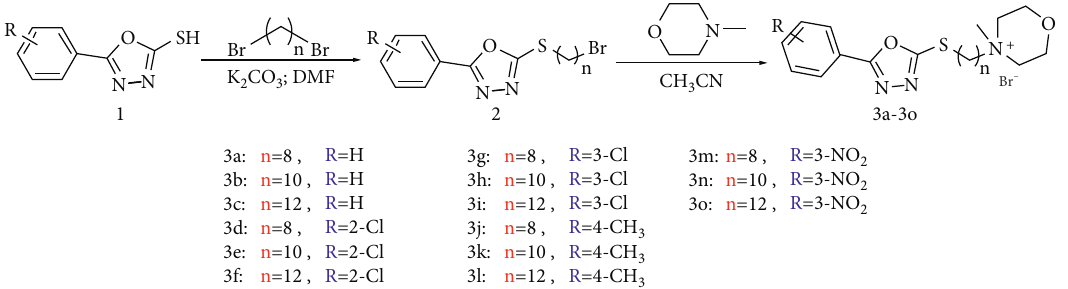
Figure 2: Synthetic route for target compounds 3a–3o . Table 1: In vitro antibacterial effects of compounds 3a–3o against Xoo and Xac .